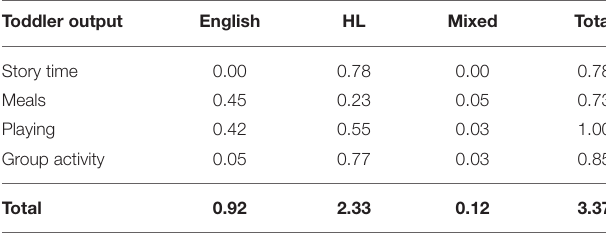
TABLE 4C | Output from toddler children in